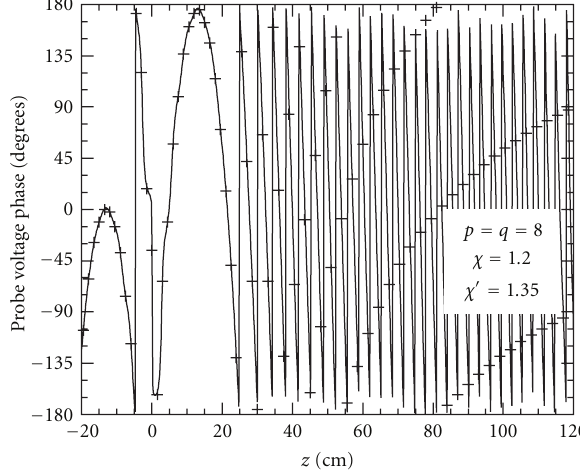
Figure 10: Far-field pattern in the E-plane. Solid line: exact field. Crosses: reconstructed from nonredundant cylindrical NF data.